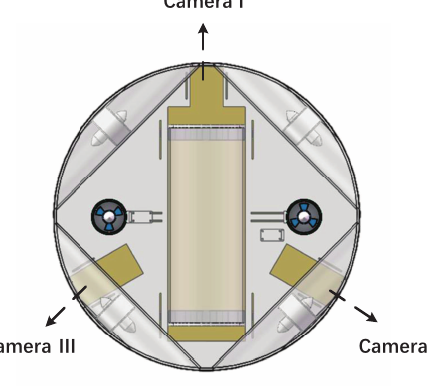
Figure 5. Top view of the internal structure of